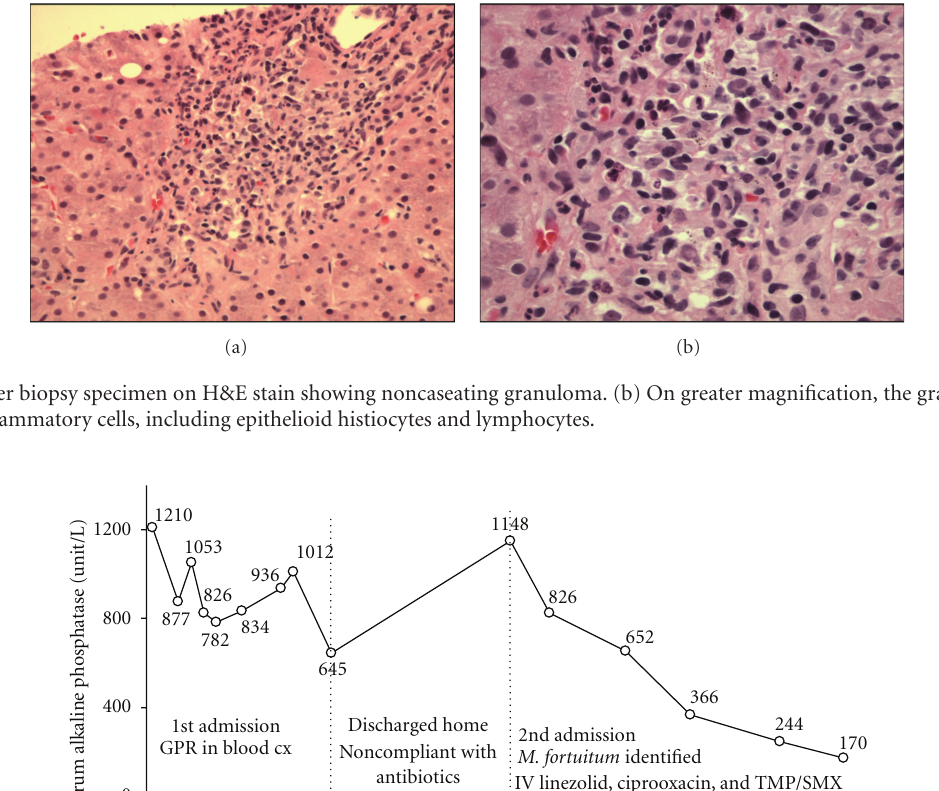
ciprofloxacin with goal of continuing the antibiotics for